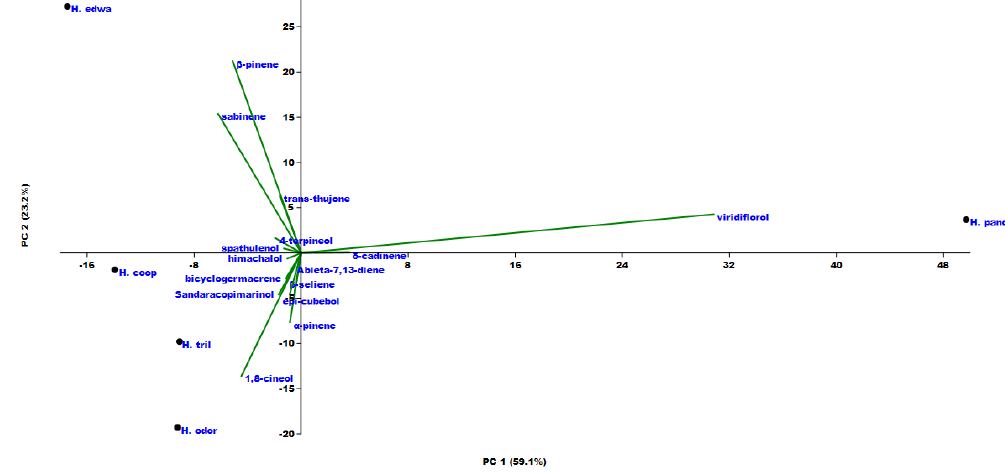
Figure 5. Principal component analysis of the EOs from the studied species of Helichrysum .